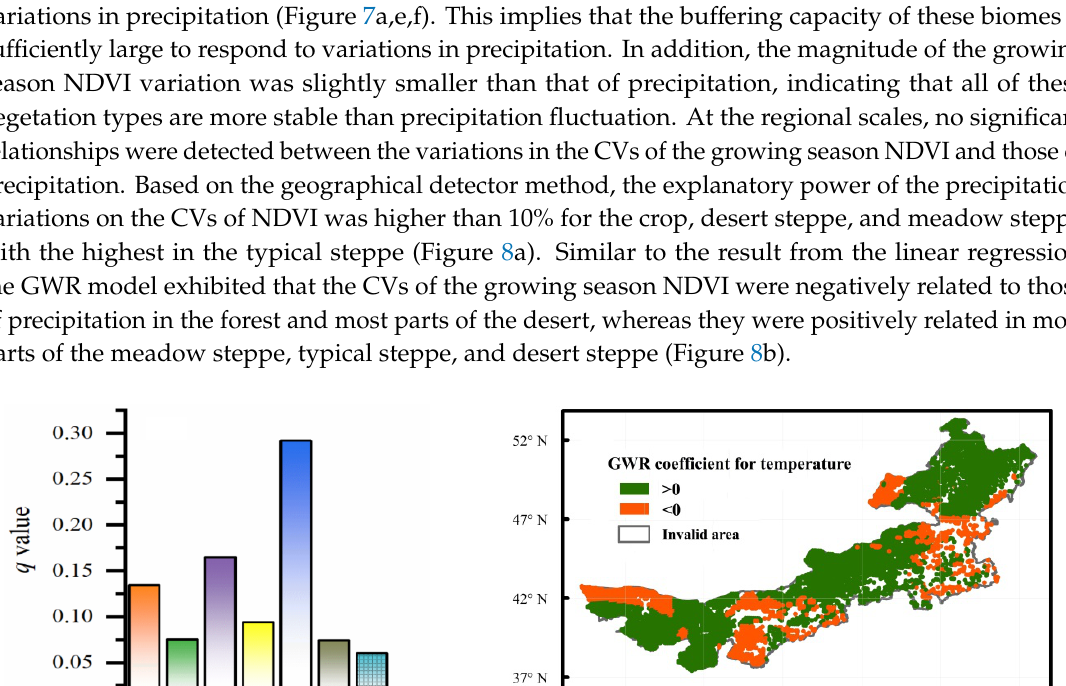
Figure 6. The power of temperature variation for determining the CVs of the growing season NDVI from the geographical detector ( a ) and regression coefficient between CVs of the growing season NDVI and those of temperature from geographically weighted regression (GWR) ( b ) during 1982–2015.